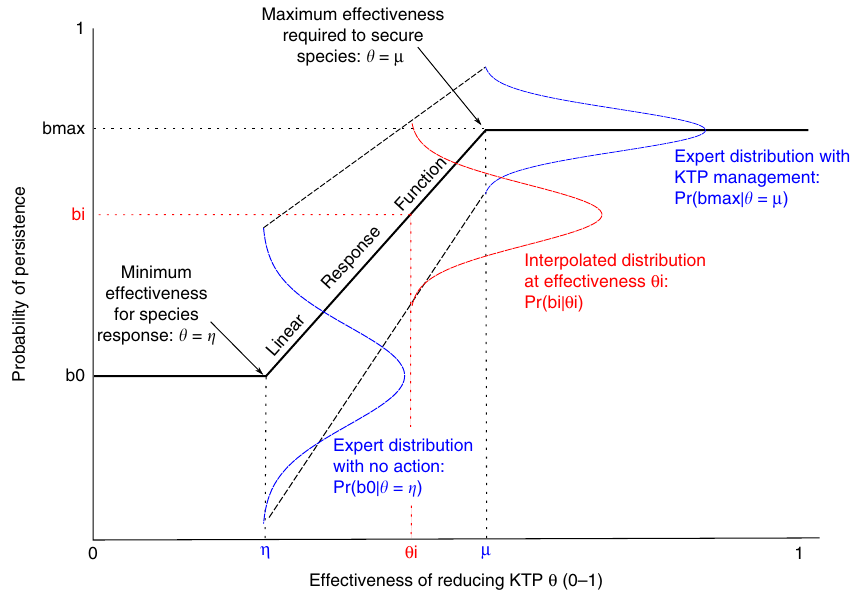
Fig. 10 Illustration of how species group response curves Pr b i j θ i ð Þ are interpolated for varying levels of threat management effectiveness. The piecewise linear response curve is the solid black line, which is generated from expert estimates. The minimum level of effectiveness required before persistence of the species group increases and the level of effectiveness required to achieve maximum persistence of the species are located at θ = η and θ = μ , respectively. Experts provide four-point estimates that parameterise beta distributions when effectiveness is 0 and 1; these distributions are illustrated in blue in the fi gure. For values of management effectiveness between η and μ , the four-point estimates given by the experts are linearly interpolated according to the relative distance of the desired point from the extremes estimated by the experts (e.g. for the mode, interpolation is between ( η , b 0 ) and ( μ , b max )). The interpolated data are then used to fi t Pr b i j θ i ð Þ at the desired management effectiveness (red curve in the fi